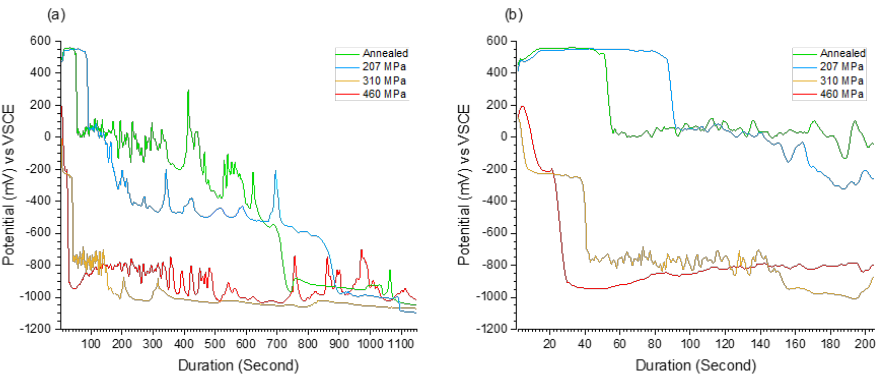
Figure 6. Galvanostatic results for specimens with different residual stress (RS) magnitudes showing 3 distinctive regions ( a ) the whole test time ( b ) the first 200 s.